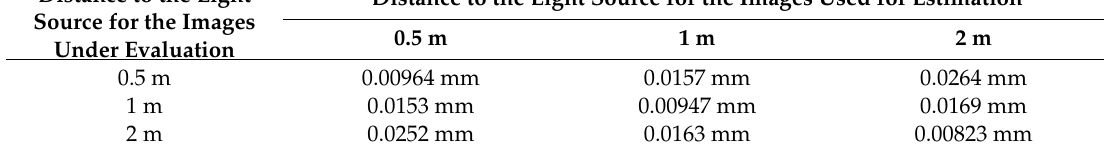
Table 2. Root-mean-square errors (RMSEs) of Euclidean distances between the positions of the light sources in the color images and mapped thermal images. Each RMSE was calculated using nine image pairs.